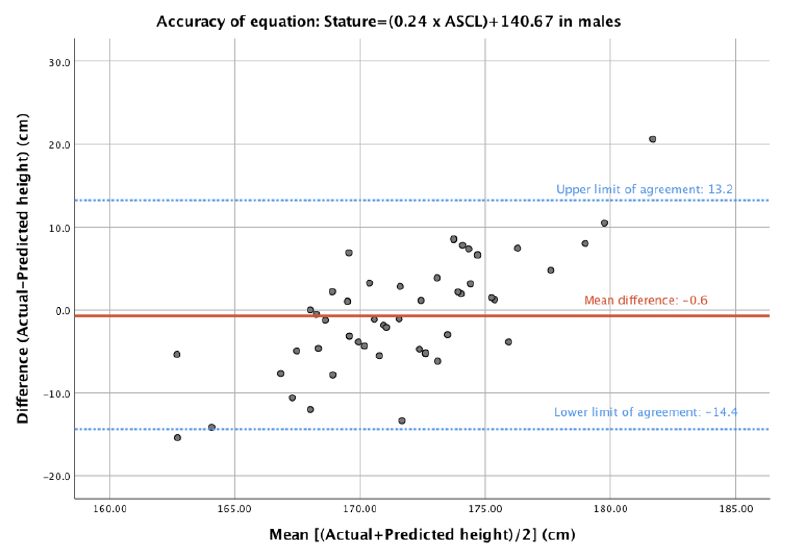
Figure 3. Bland–Altman plot of difference (actual—predicted height) and mean (of actual and pre-